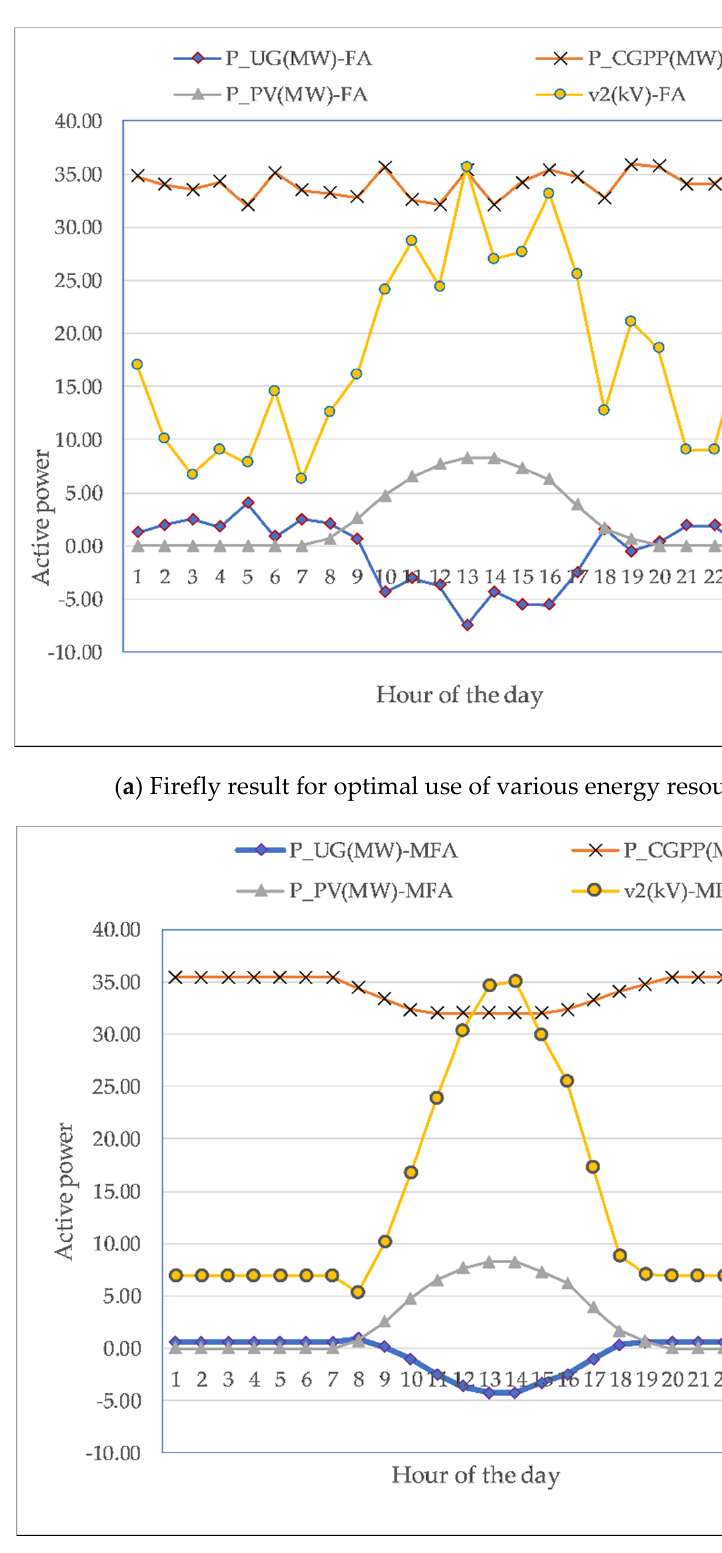
Figure 8. Active power sharing and voltage at bus 2. Table 9. Power flow results of all optimization techniques.